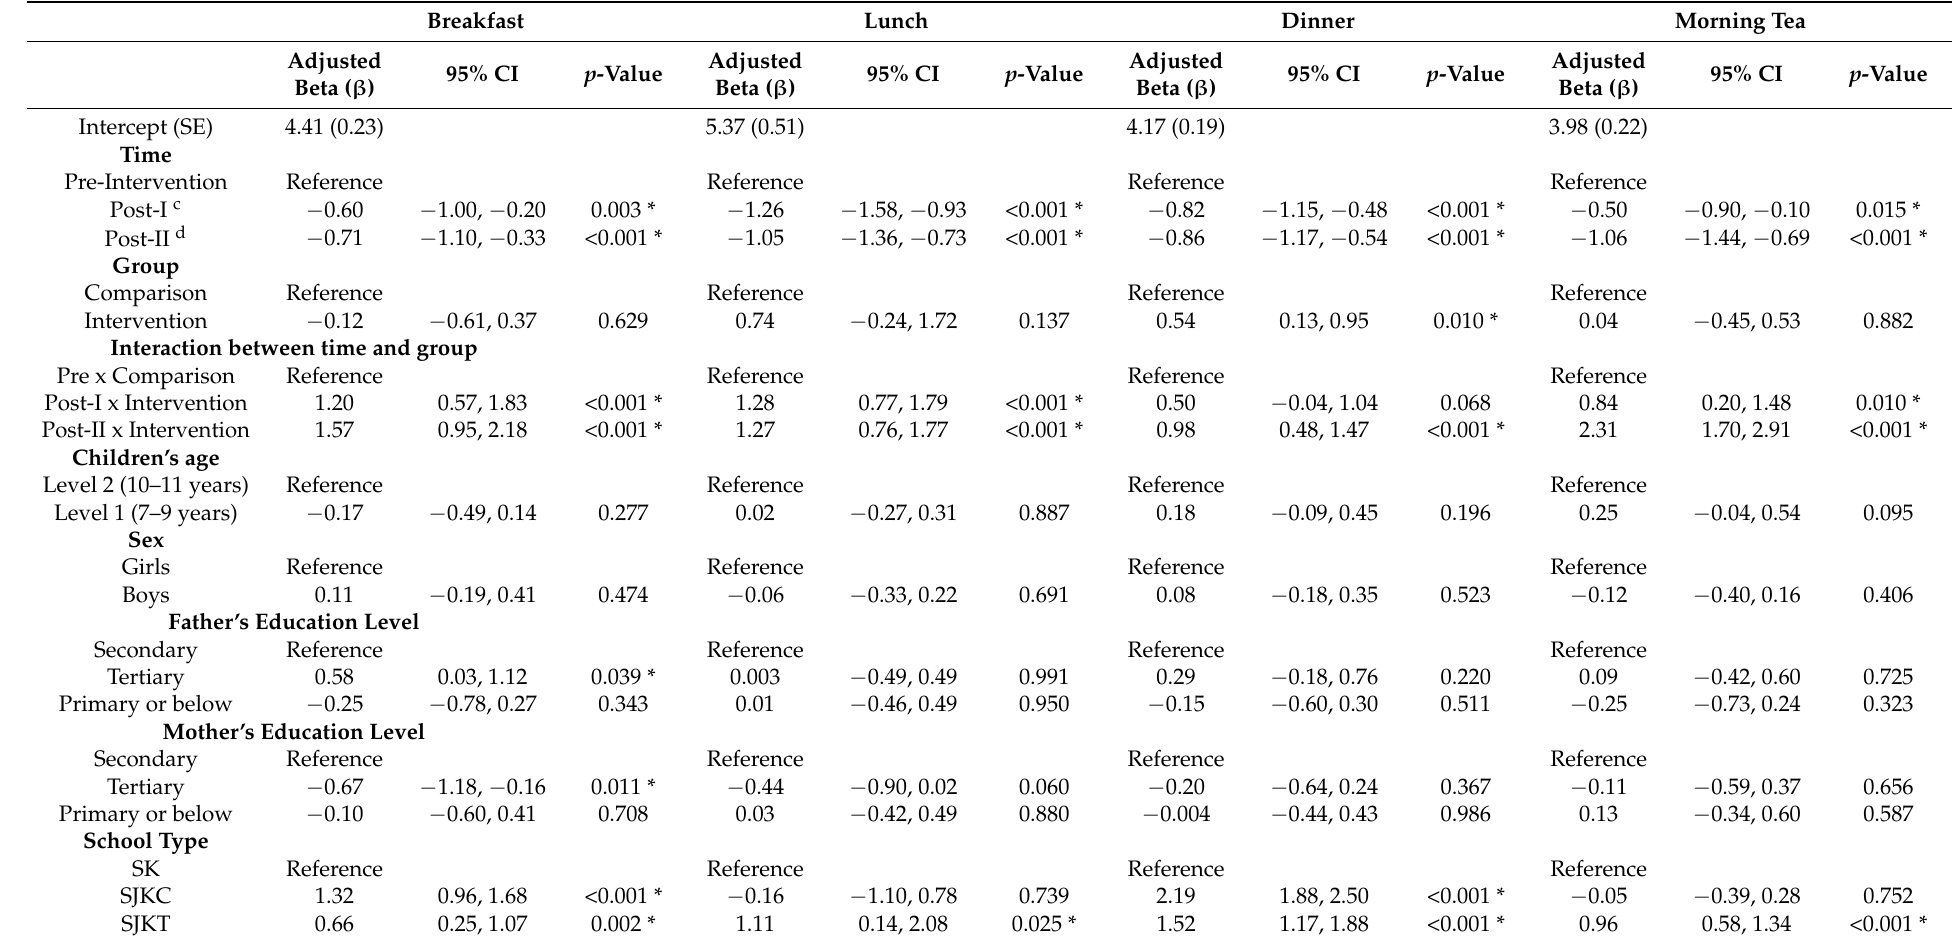
Table 3. Changes in eating behaviors and physical activity, adjusted with covariates b